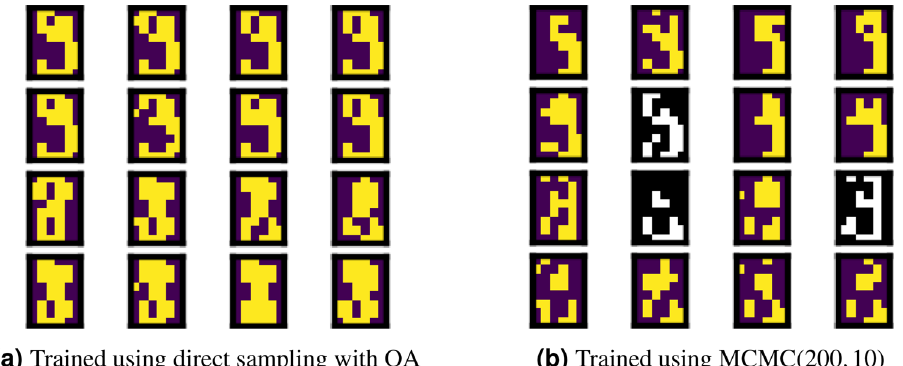
Figure 8. Images generated using MCMC(200, 10) at epoch 4000.